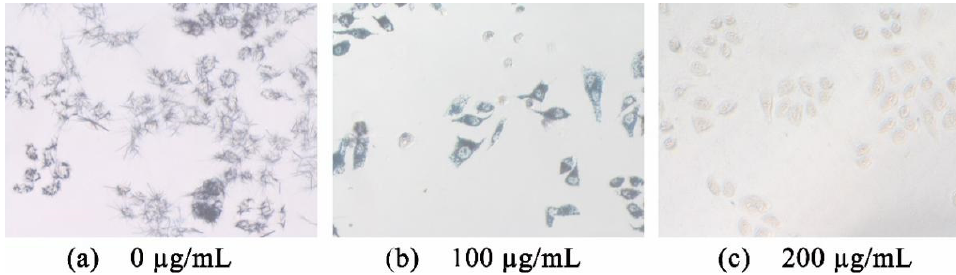
Figure 3. Antitumor activity of L-POcQAS-M 50 at different concentrations (0 ( a ), 100 ( b ), and 200 ( c ) μ g/mL) on MK-28 gastric cancer cells .